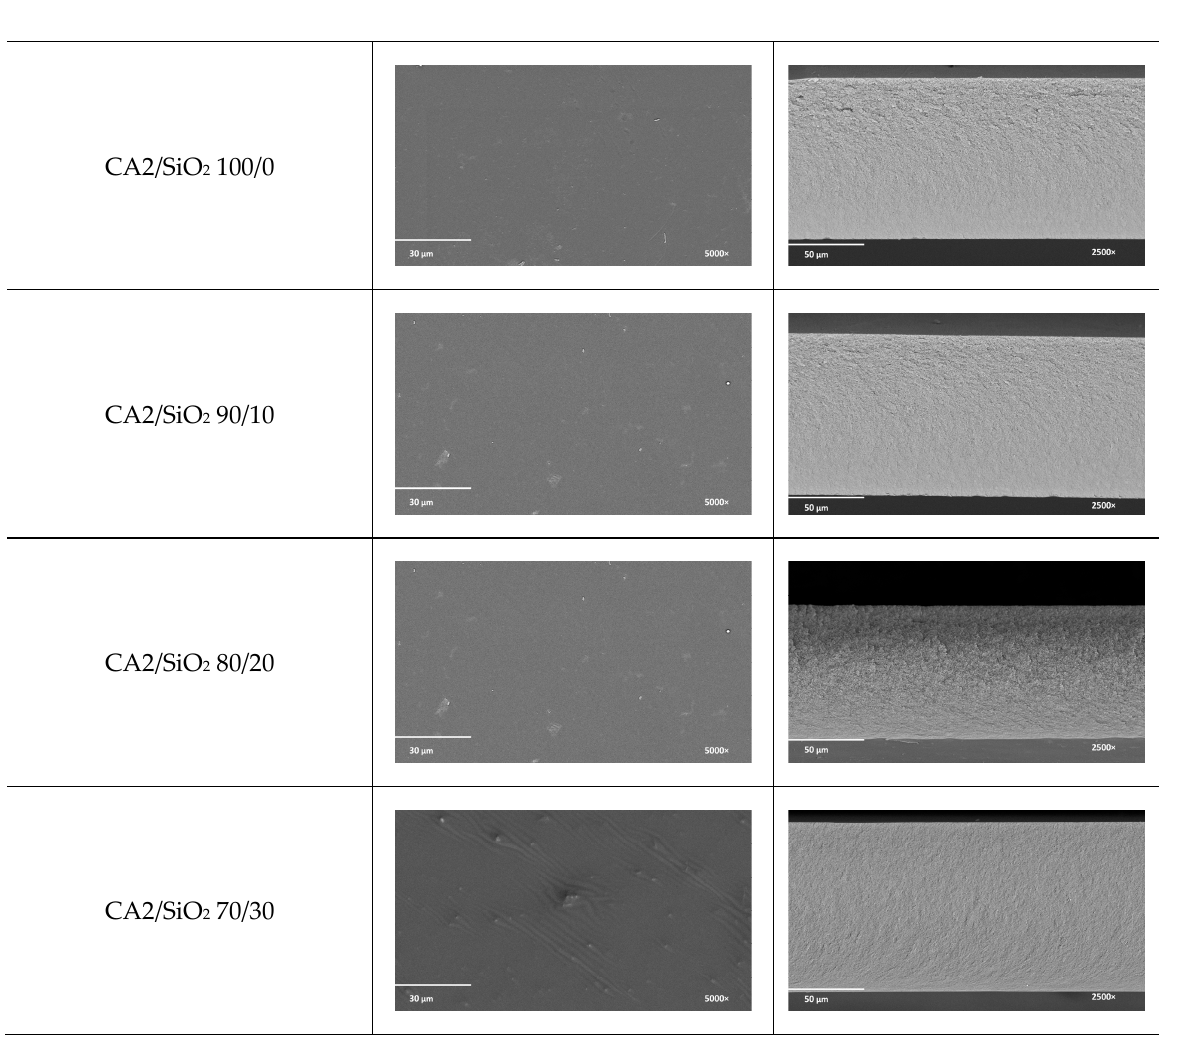
Figure 4. Top dense surface and cross-sectional images for the series one and series two membranes at 5000× and 2500× magni fi cation. at 5000 × and 2500 ×